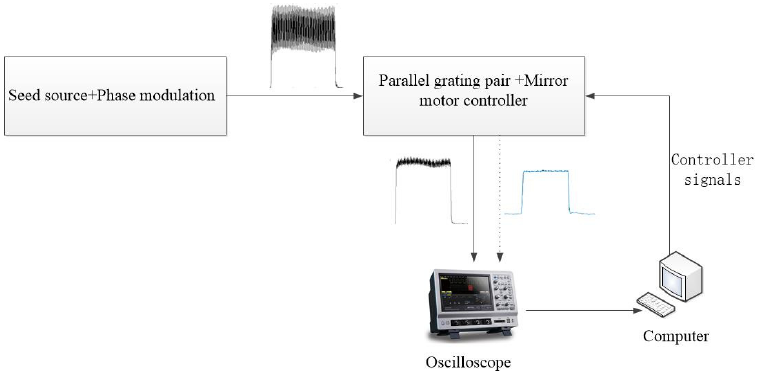
Figure 2. Schematic of compensation